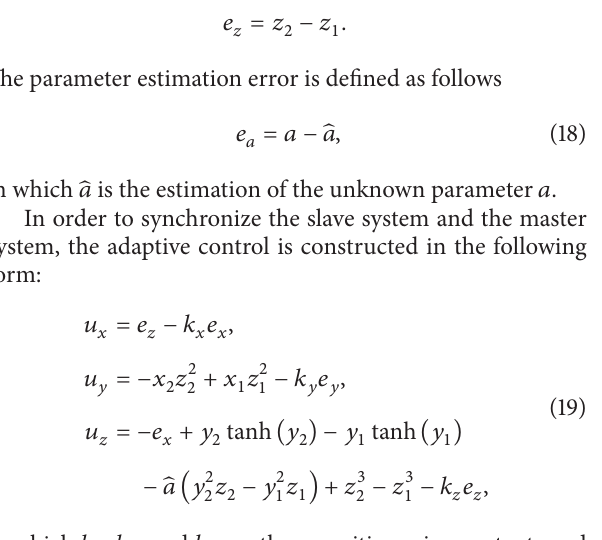
Figure 5: The quadrilateral subset 𝐷 1 and its image.